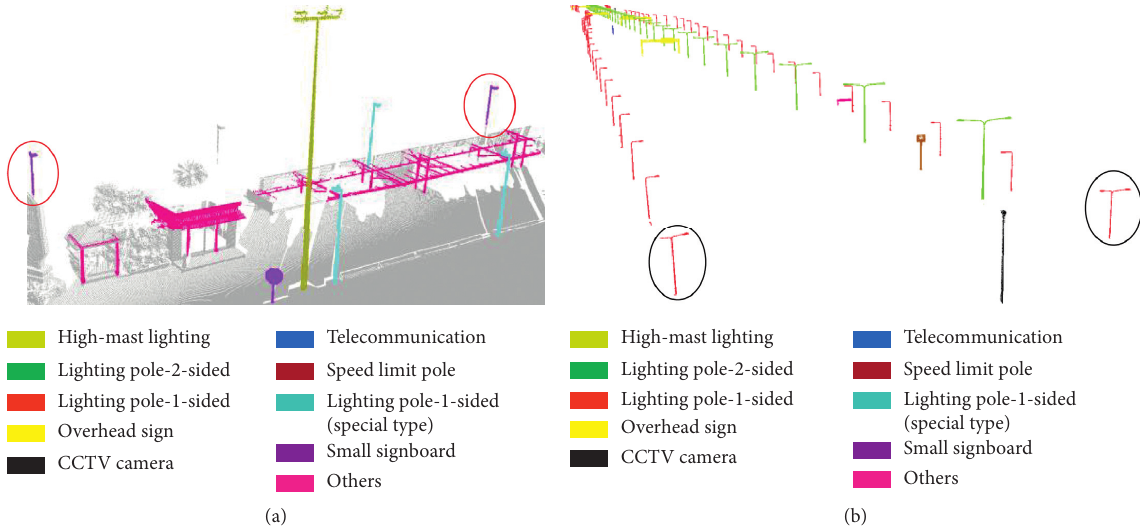
Figure 18: Classification results at Site 2. (a) The lighting pole-1-sided (special type) was mislabeled as a small traffic signboard. (b) The lighting pole-2-sided was misclassified as a lighting